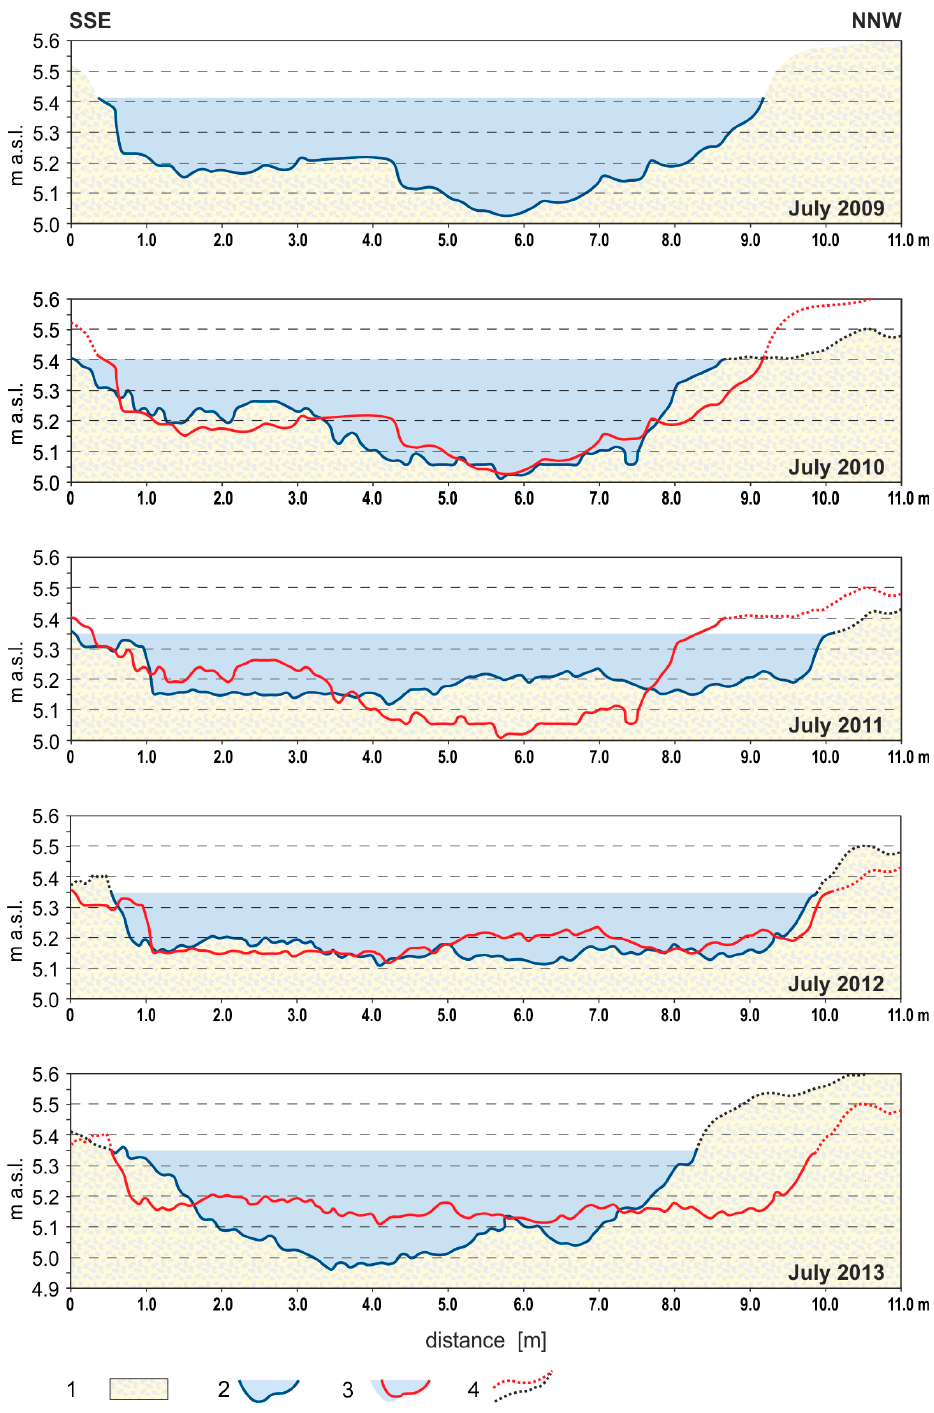
Figure 3. Changes in the channel bottom in XS I between 2009 and 2013: 1. Bedrock, 2. Current stage, 3. Previous stage (last season), 4. Dry streambank.